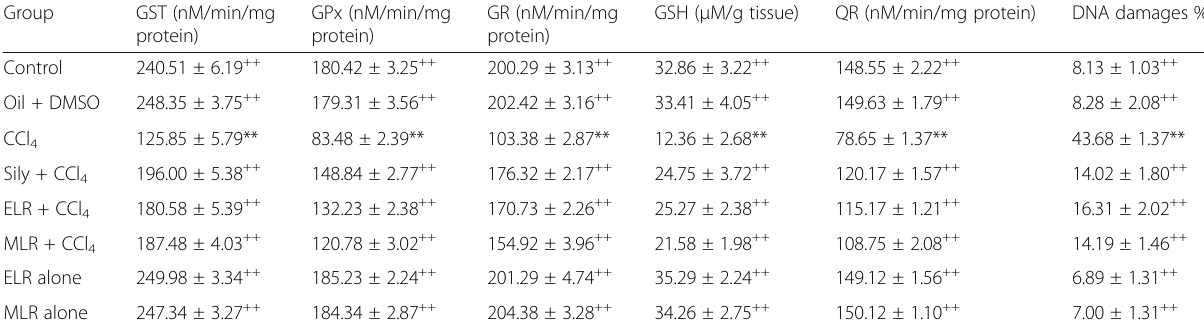
Table 4 Effects of various fractions of R. hastatus leaves on phase II antioxidant enzymes and DNA fragmentation Group